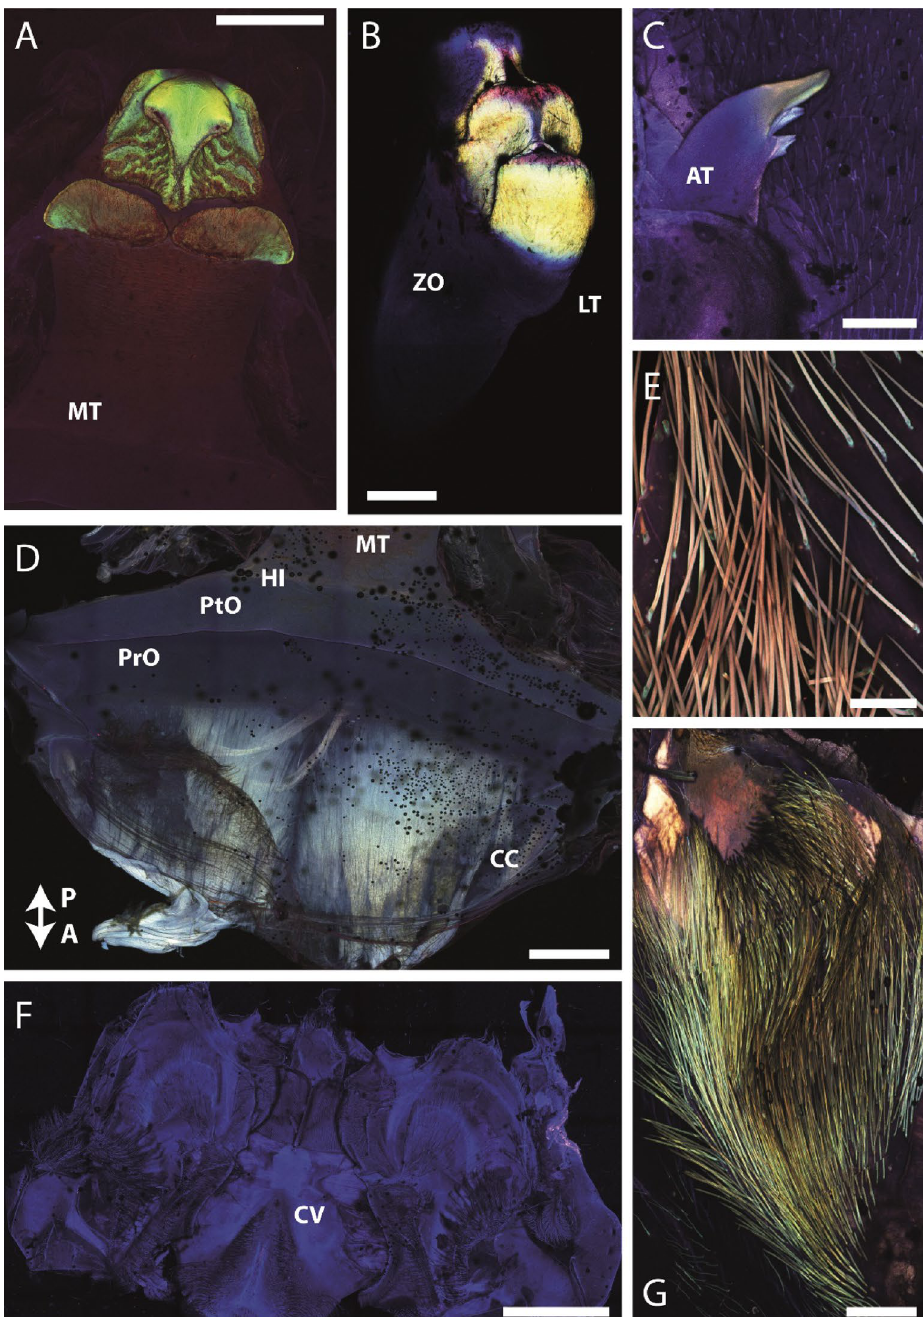
Figure 4. CLSM images of the components of the gastric mill. Comparison of colors is only possible within each individual image, as they were taken individually. ( A ) Medial tooth. ( B ) Lateral tooth. ( C ) Accessory tooth. ( D ) Basis of medial tooth and cardiac chamber. The arrow points in the anterior and posterior direction. ( E ). Setae with high magnification. ( F ) Cardiopyloric valve and surrounding structures. ( G ) Setae and surrounding membrane. A anterior, AT accessory tooth, CC cardiac chamber, CV cardiopyloric valve, HI hinge of medial tooth, LT lateral tooth, MT medial tooth, P posterior, PrO prepterocardiac ossicle, PtO pterocardiac ossicle, ZO zygocardiac ossicle. Scale bars: A, 750 µm; B, 200 µm; C, 400 µm; D, 750 µm; E, 20 µm; F, 1500 µm; G, 100